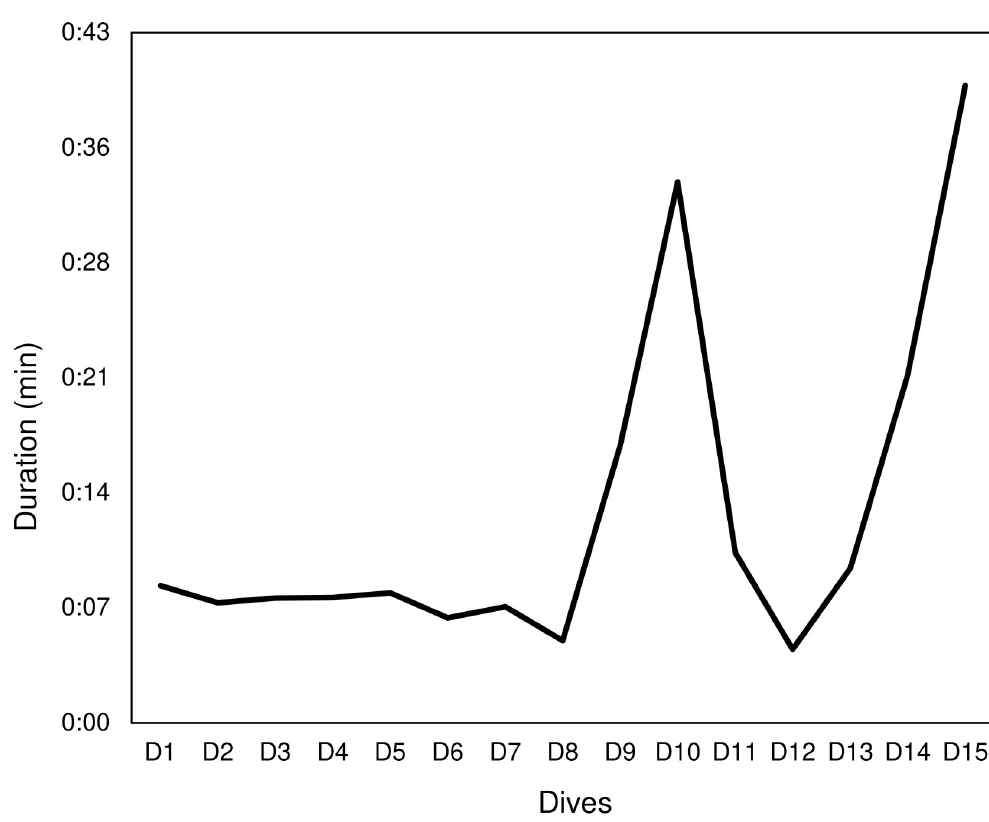
Fig 7. Duration (minutes) of each dive (from D1-D15) for the second